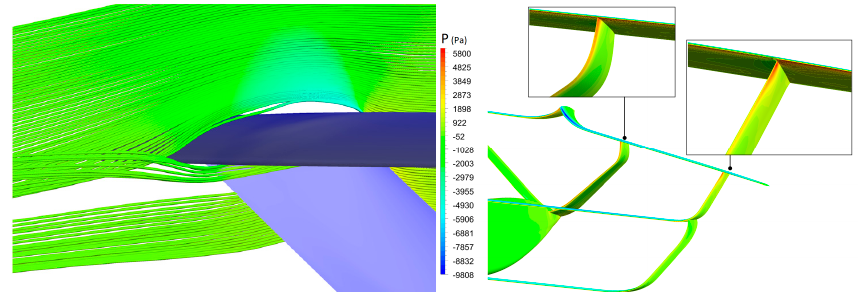
Figure 18. BWA/SL aircraft in flight conditions S3 (M = 0.7 at 43,000 ft) with an angle-of-attack α = 0° ( left ) and S 1 (M = 0.85 at 44,000 ft) with angle-of-attack α = 3° ( right ). Flow dynamics at the outboard, straight junction of third wing, with swirling streamlines ( left ) and absolute pressure ( right ).